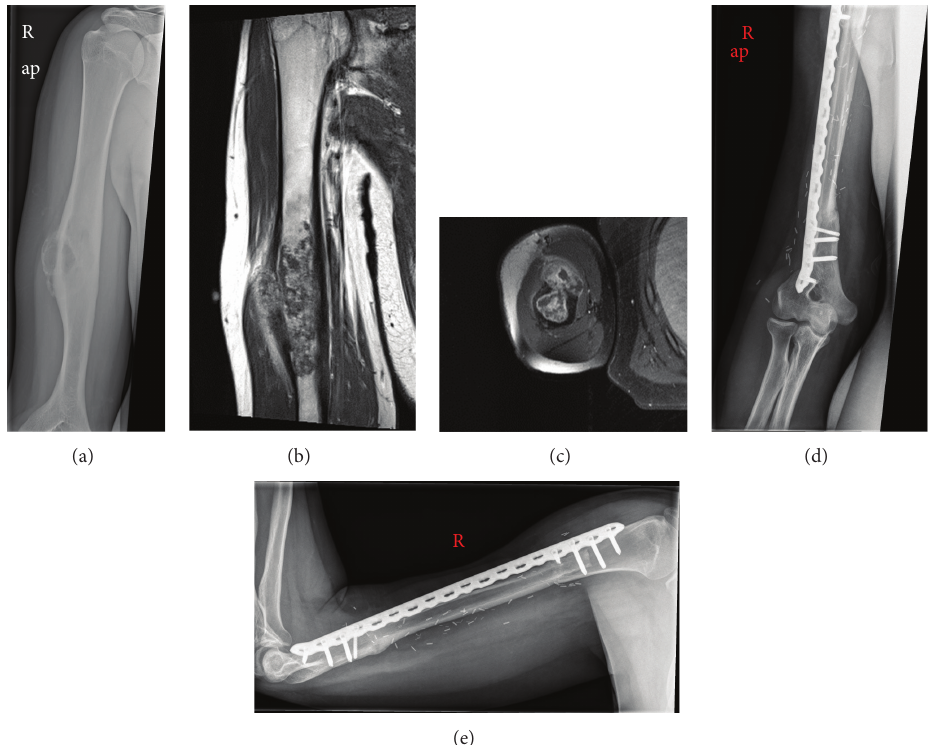
Figure2:ChondrosarcomaG2attheproximalhumerusshownintheX-ray(a)andMRI((b),(c)).Nine-monthpostoperativeX-raysshowing the reconstruction after wide resection with an autologous free vascularized fibula graft ((d), (e)).